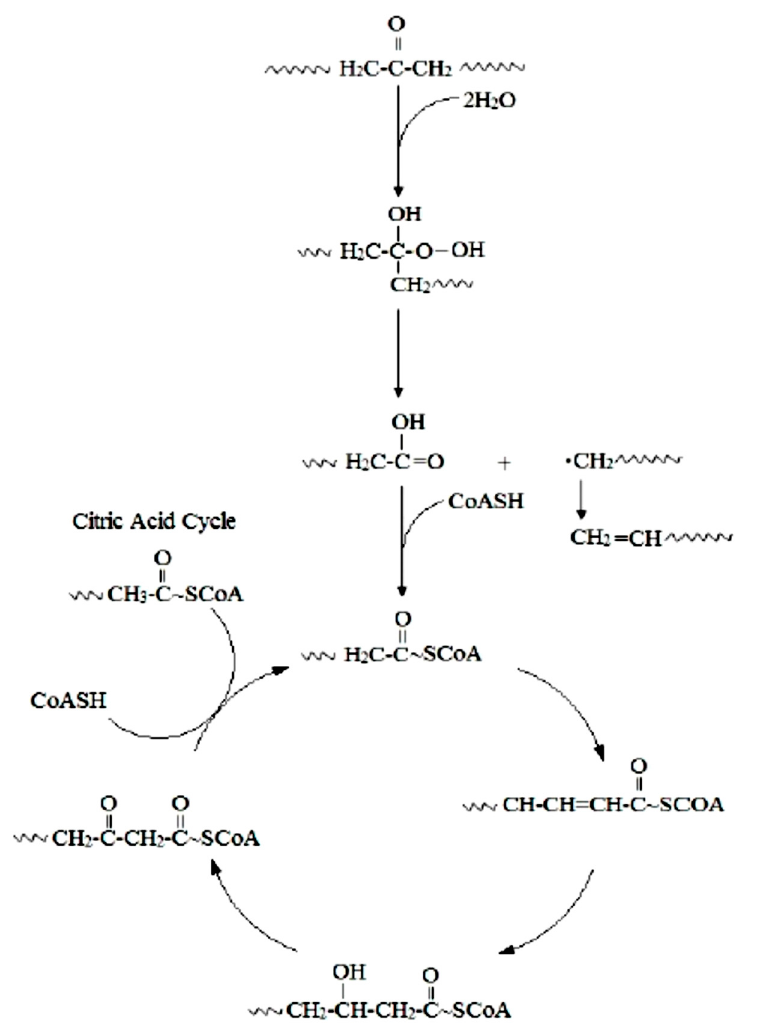
Figure 1. Mechanism for the biodegradation of PE [36].